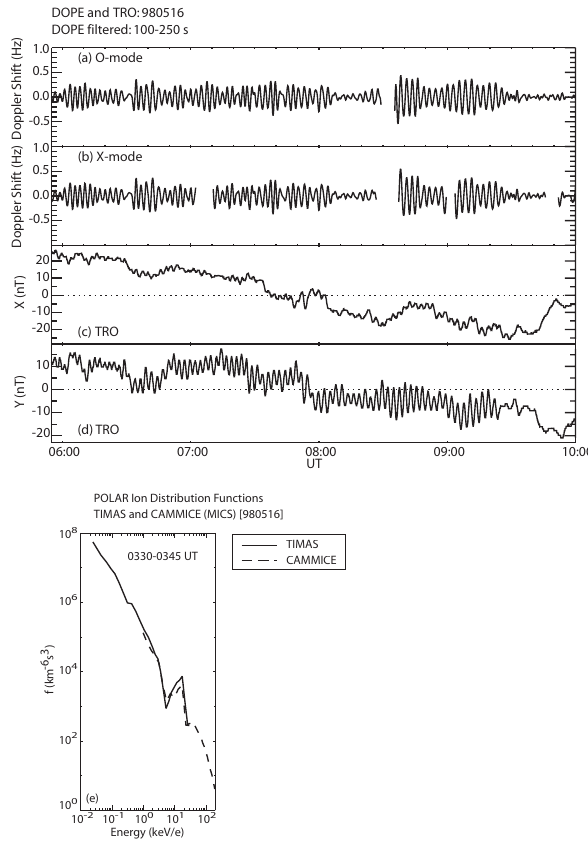
Figure 8. Fig. 8. (Taken from Wright et al. 2001, described as case study 2 in this paper) ( a ) O- and ( b ) X- mode, HF Doppler sounder data from DOPE and ( c ) X and ( d ) Y component ground magnetome- ter data at Tromsø for 06:00–10:00 UT on 16 May 1998 during the occurrence of a giant pulsation (Pg). ( e ) The conjugate driv- ing ion distribution functions, IDFs, derived from the TIMAS and CAMMICE (MICS) instruments for the interval on 16 May 1998, 03:30:00–03:45:00